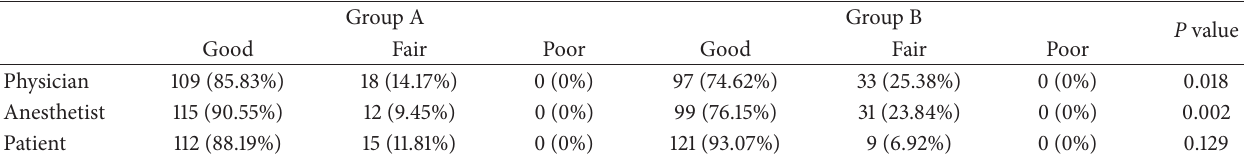
Table 4: Satisfaction of physician, anesthetist, and patient with the 2 treatments.